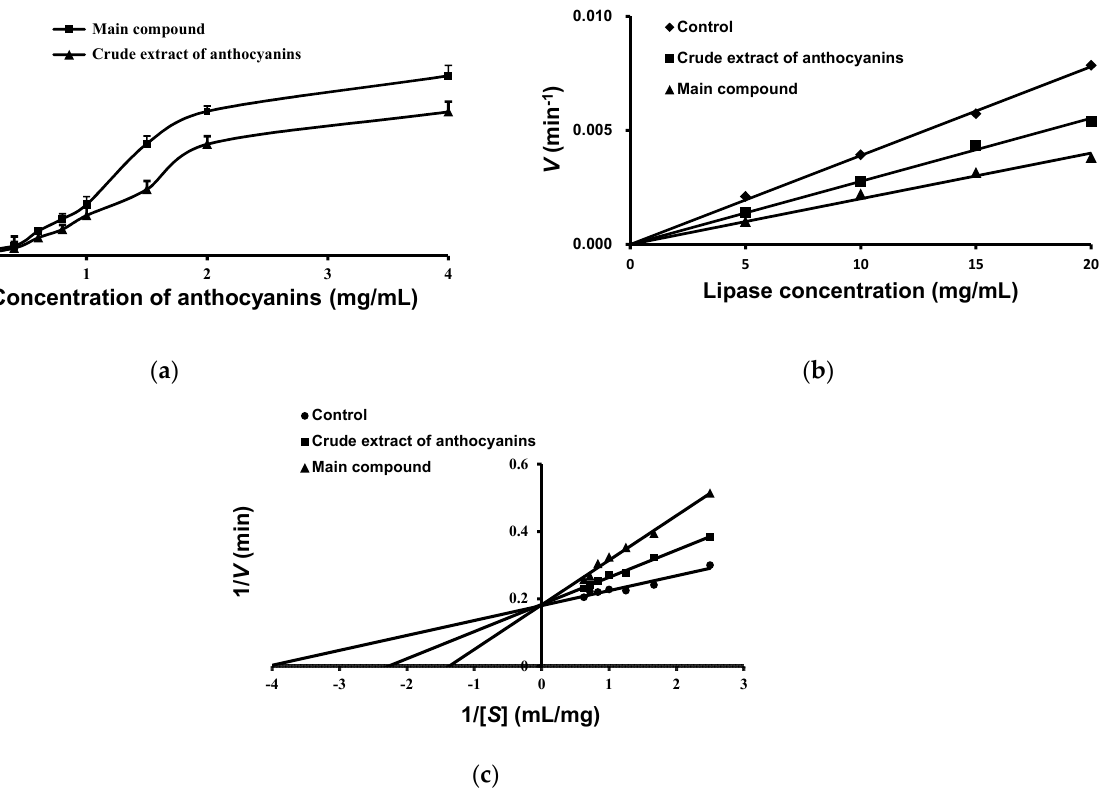
Figure 6. The inhibitory effect of anthocyanins from the fruits of L . ruthenicum on pancreatic lipase activity. ( a ) The inhibitory effect of anthocyanins on pancreatic lipase activity. ( b ) The inhibitory type of pancreatic lipase by anthocyanins. ( c ) The Lineweaver–Burk curve analysis of the inhibition kinetics of the lipase inhibitory effects of anthocyanins. Table 4. The K sv , K q , K a , and n valuesofanthocyaninsfromthefruitof L.ruthenicum atdifferenttemperatures. Groups